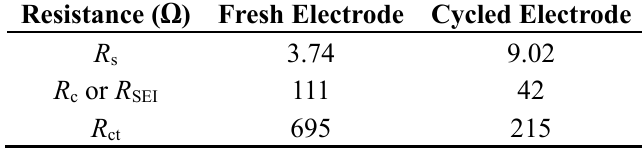
Table 1. Impedance parameters based on the equivalent circuit above for both the fresh and cycled Co 3 O 4